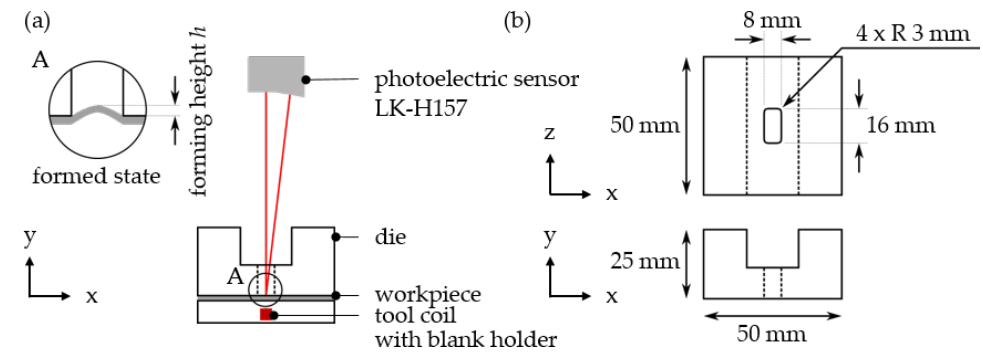
Figure 1. Experimental setup: ( a ) sketch of the setup ( b ) drawing of the die.